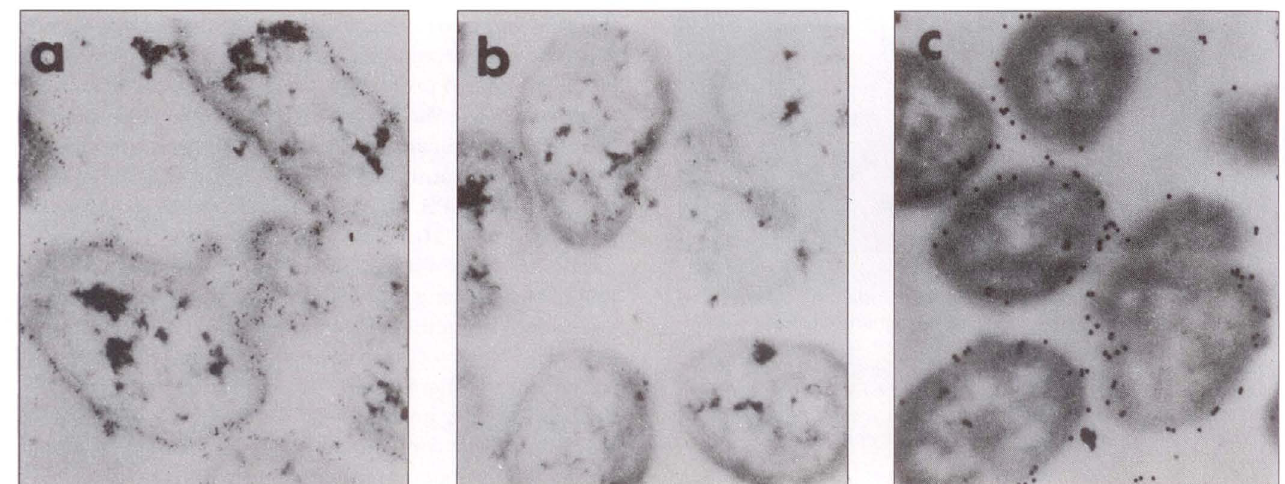
Figure 4) a Strain 1291 viewed by electron microscopy has the conserved component with the terminal group treated with a monoclonal antibody (MAb) that recognizes the group. followed by secondary antibody and small gold particles; b After cytidine 5'